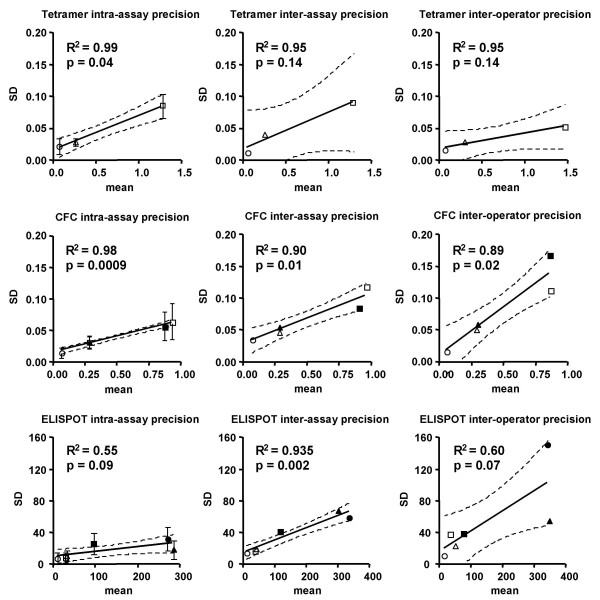
SD of each assay. The mean response for each sample (as per Figure 1) was plotted versus the SD of six replicates (intra-assay precision), eight assays on different days (inter-assay precision), or three operators on the same day (inter-operator precision). Circles represent donor 41; triangles, donor 68; and squares, donor 43. Open symbols represent CMV pp65495–503 responses; closed symbols represent CMV pp65 peptide mix responses (CFC and ELISPOT assays only). Error bars in the intra-assay graphs represent the SD of 10 times that the six replicates were repeated. Lines represent linear regression of the combined data (both antigens, where used), with 95% confidence intervals of the regression shown with dotted lines.